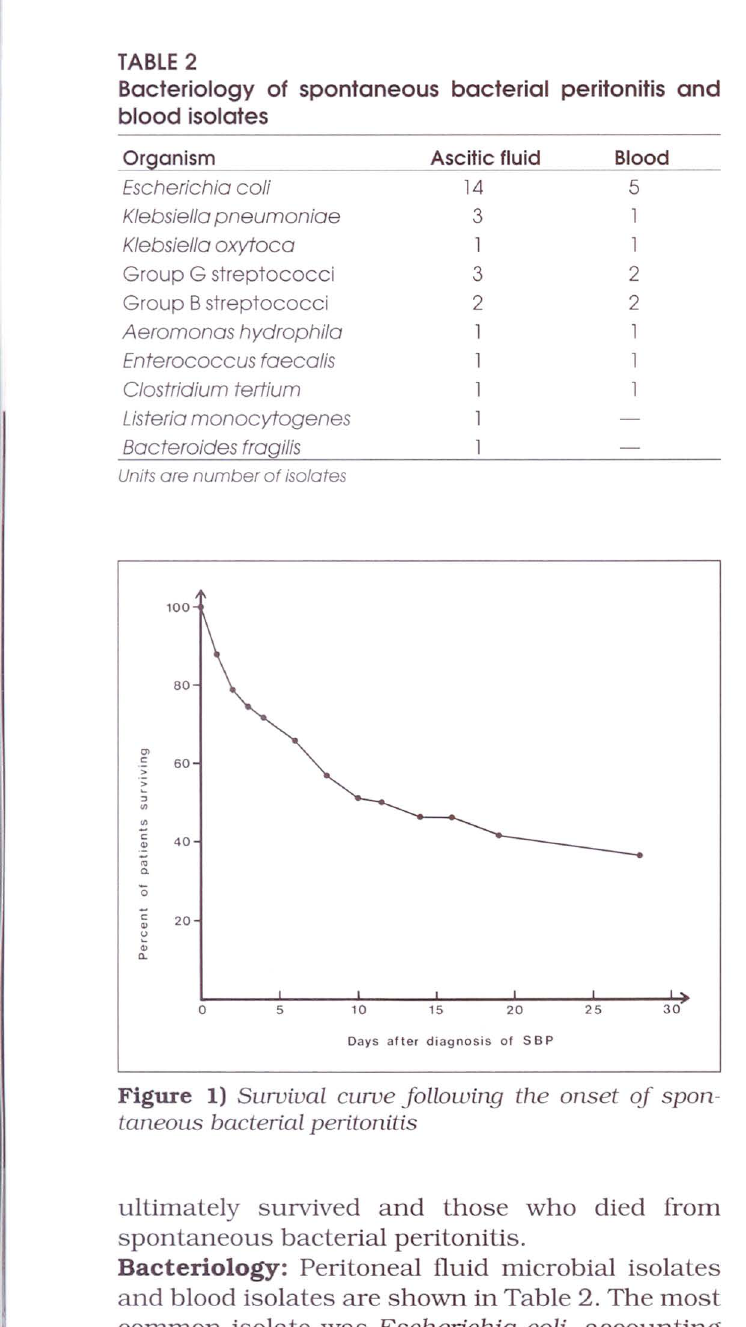
ultimately survived and those who died from spontaneous bacterial